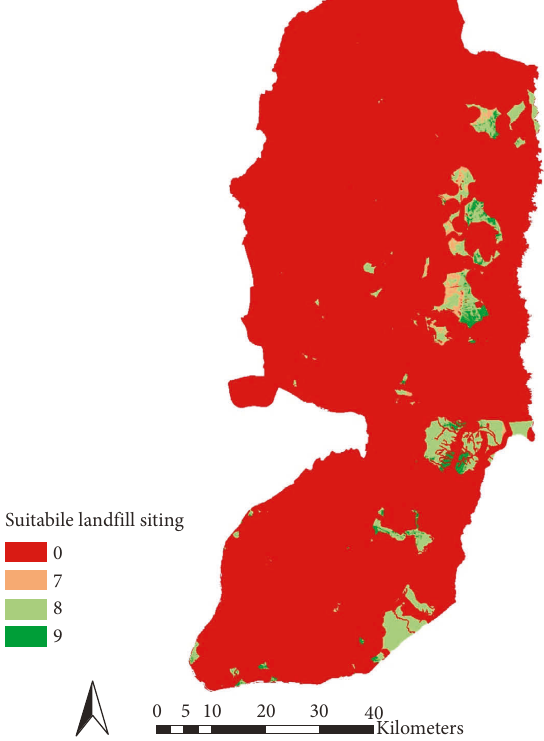
Figure 6: Suitable landfill siting areas (map prepared by researcher, dataset source: GeoMoLG).